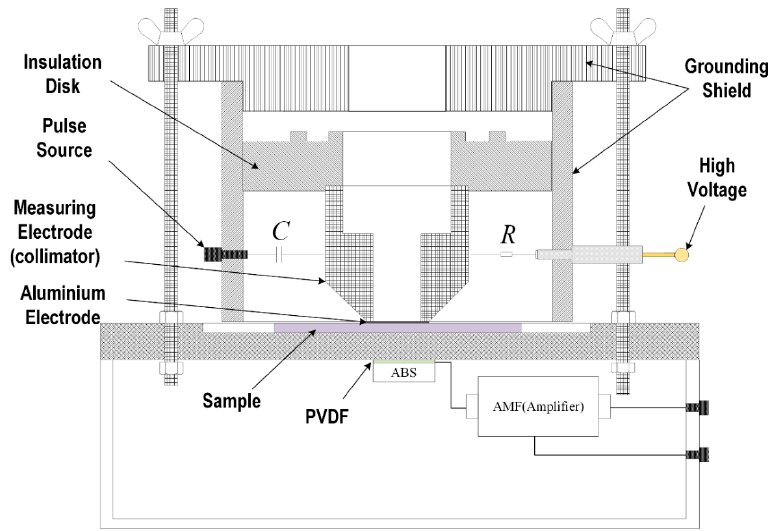
Figure 1. Measurement electrode system for space charge distribution under high-energy electron radiation.